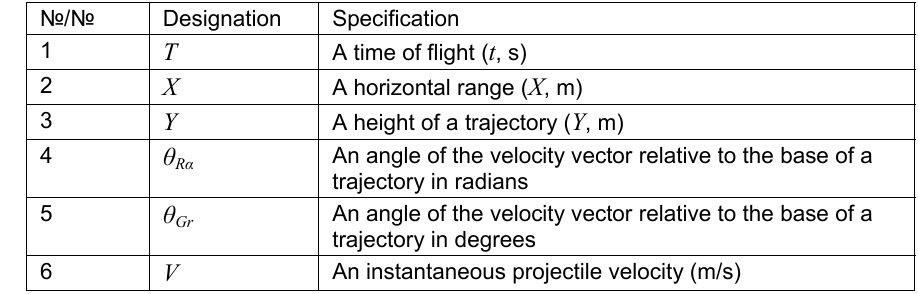
Table 3 – Characteristics of variables of a numerical solution of the system of ODEs